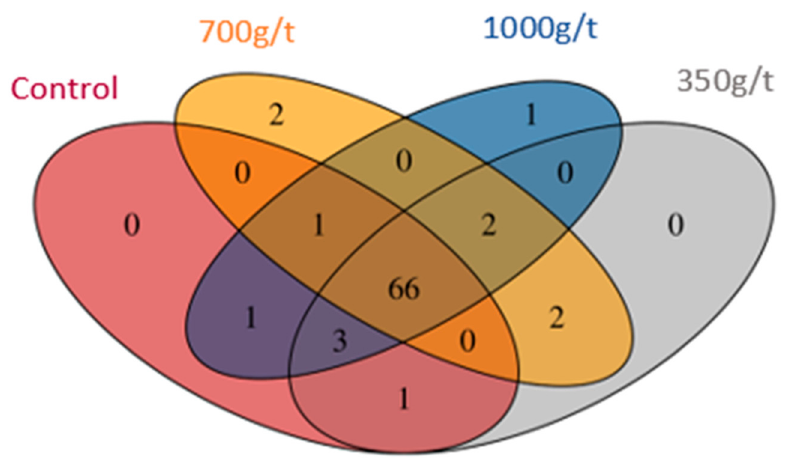
Figure 5. Core microbiota analysis was carried out at the genus level, including the top 100 relatively abundant OTUs present, to visualize the differences between the samples, based on diet groupings.